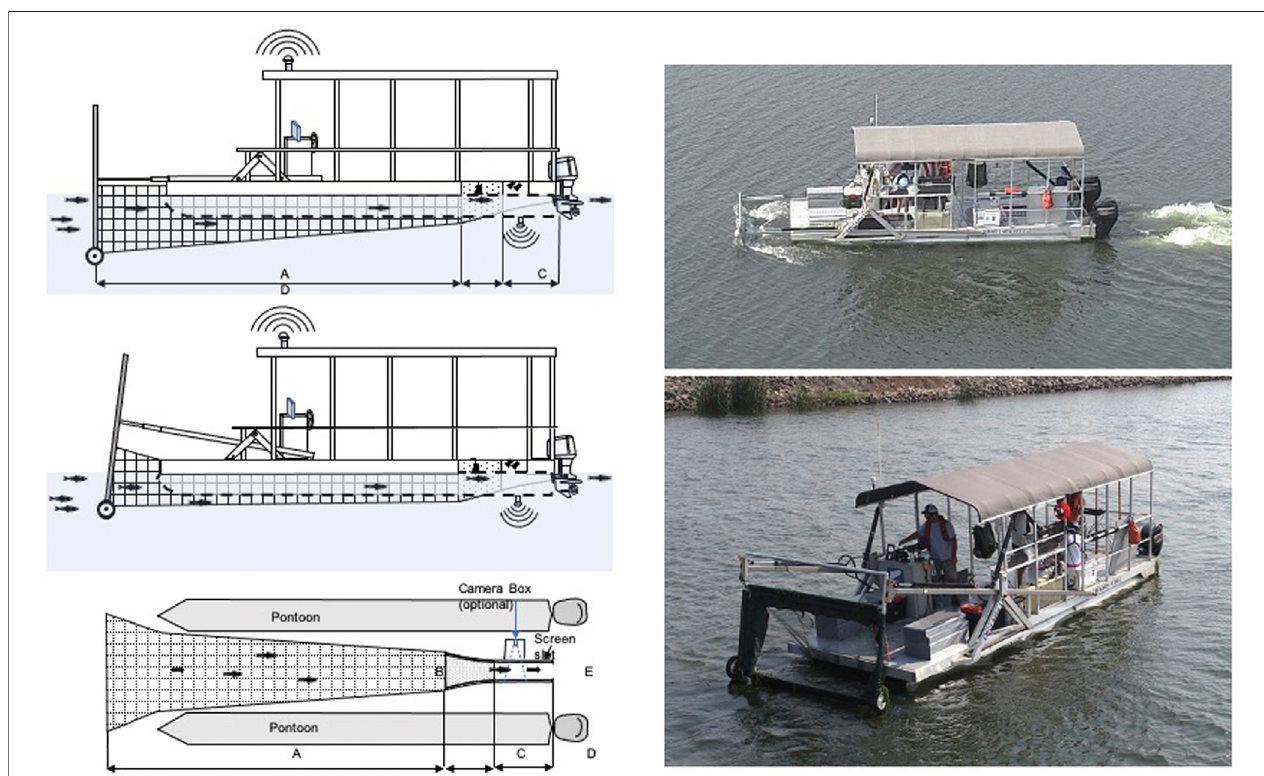
FIGURE 2 | Left Top: Diagram of the Single-Platform Aquatic Species and Habitat Sampling System (Platform). Vertically adjustable fyke net (surface to 3 m) fi ts between two pontoons (transparent in illustration to show live box) and terminates at live box near vessel aft where video images, captured fi sh, and water quality parameters are recorded. Wheels at the rigid net frame bottom allow rolling over benthos in shallow water. Left Middle: Hydraulic net frame can be adjusted to compensateforwaterdepthand nettension.LeftBottom: Top-down diagram ofPlatform (work deckremoved) displaying theconcentratornet (Alength (cid:2) 5.5 m), andlivebox[Bopening (cid:2) 68.6 cmwide;Cperforatedaluminum(6 mmholes)section (cid:2) 105.9 cmlong;Dsolidaluminumplatesection (cid:2) 83.5 cmlong,andEliveboxexit (cid:2) 32.9 cmwide].Screenismountedintoslotforactive fi shcapturebutcanberemovedforpassive fl owthroughinconjunctionwithoptionalcamerabox(notusedinthis study). Right Top: Platform operating with net fully submerged within Mildred Island. Right Bottom: Platform with net fully retracted from